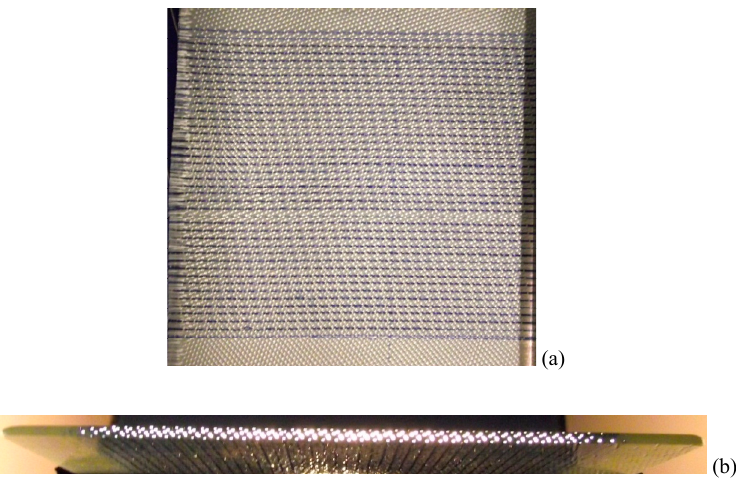
Figure 11. ( a ) Photograph of a co-woven SDOF/E-glass fabric; ( b ) Photograph showing the SDOFs transmitting white-light from the edge of the composite.